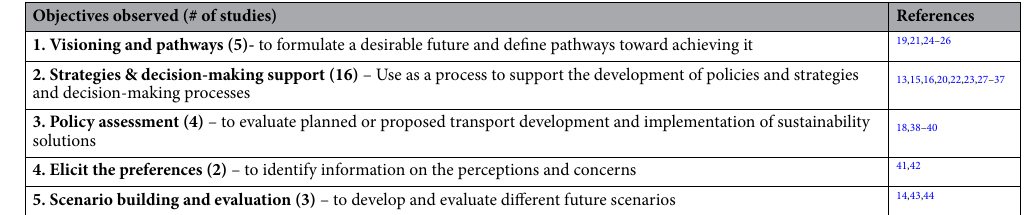
Table 1. Five objectives of the participatory vision making process observed in the literature.